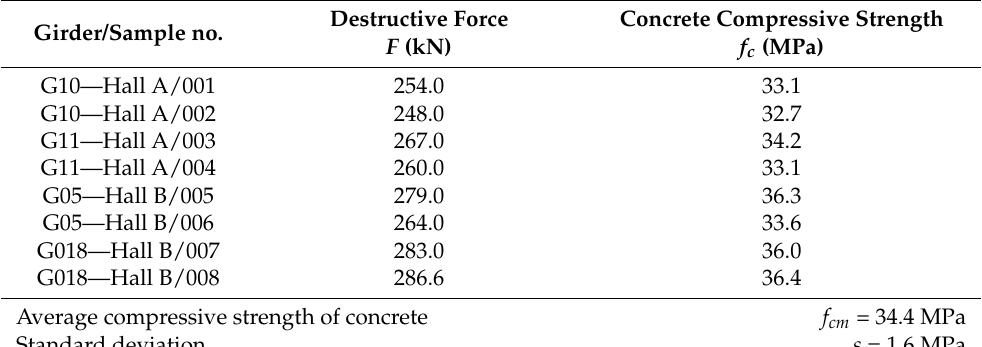
Table 6. Determining the strength of structural concrete (girders G10 & G11—Hall A, girders G05